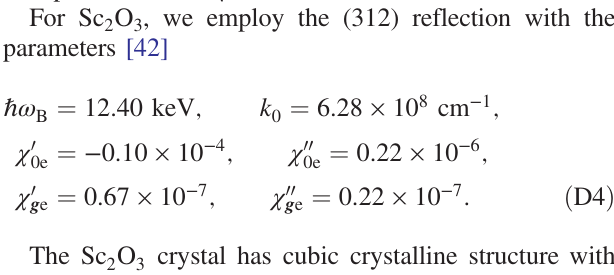
factors are S ð g Þ ¼ − 4 for 121 51 Sb and S ð g Þ ¼ 4 for 49 In. The isotopic abundance η ¼ 0 . 5725 .